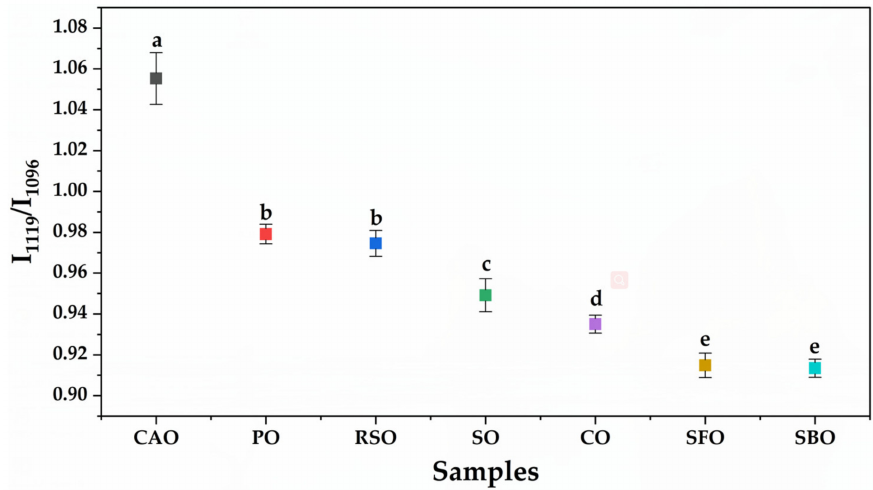
Figure 2. Clustered FTIR band identity ratios of I 1119 / 1096 of di ff erent oils are shown in the